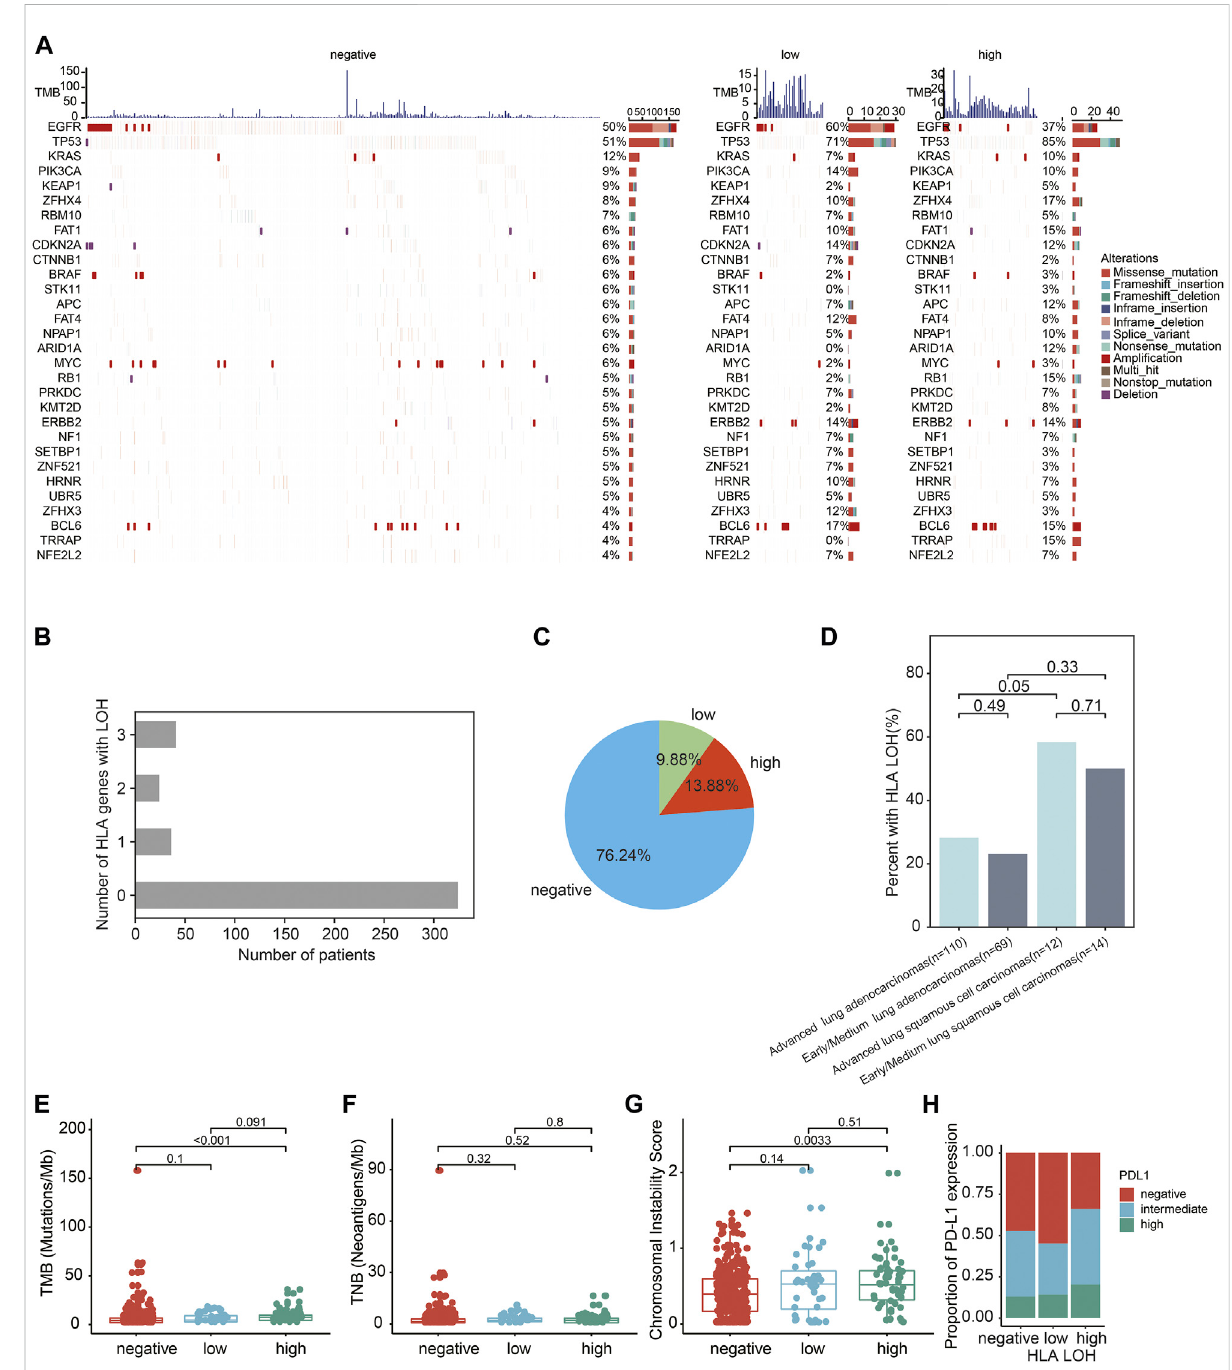
FIGURE 1 Genomics characteristics of Chinese lung patients with different HLA LOH statuses. (A) Genomics landscape of tumor with HLA LOH negative, HLA LOH low and HLA LOH high. The top histogram was the value of TMB. The Center heatmap is the distribution of the top 30 non-synonymous driver mutation events from patients. (B) The number of patients with HLA LOH negative, HLA LOH low and HLA LOH high in 425 lung cancer patients (C) The percentage of HLA LOH negative, HLA LOH low and HLA LOH high in 425 lung cancer patients. (D) The occurrence of HLA LOH in the NSCLC patients. (E – H) Associations between HLA LOH and TMB (E) , TNB (F) , CIN (G) and PD-L1 expression (H)